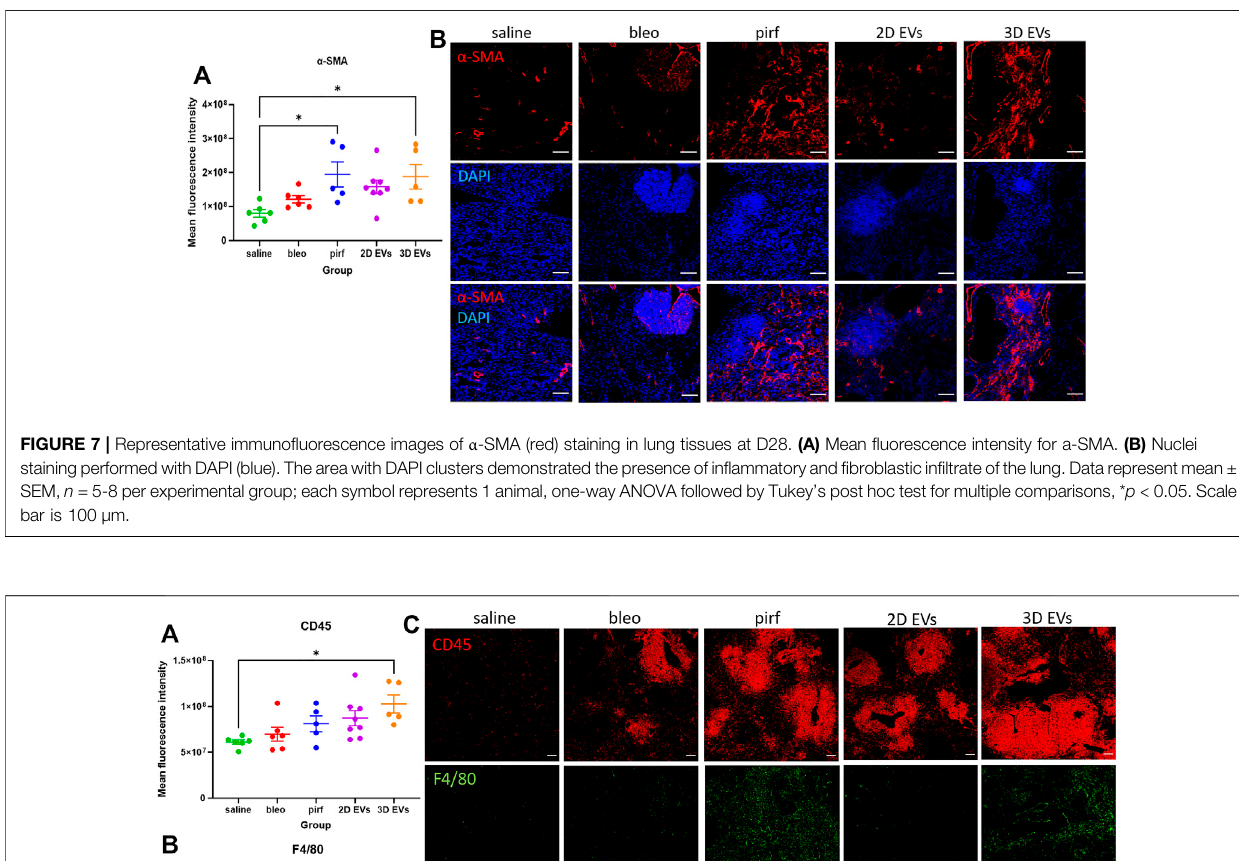
Frontiers in Cell and Developmental Biology |